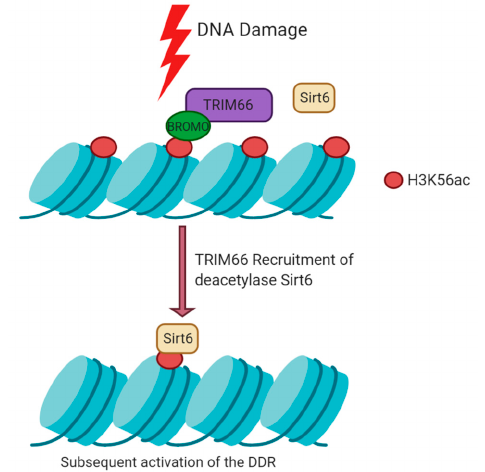
Figure 3. TRIM66 Response to DNA damage. In response to damage, TRIM66 is recruited to damage sites, where it recognises H3K56ac via its bromodomain (BROMO) and unmodified H3R2K4 via its PHD domain (not shown). TRIM66 recruits the deacetylase Sirt6 to rapidly remove H3K56ac marks to facilitate DNA repair. These marks are restored at later stages of DNA